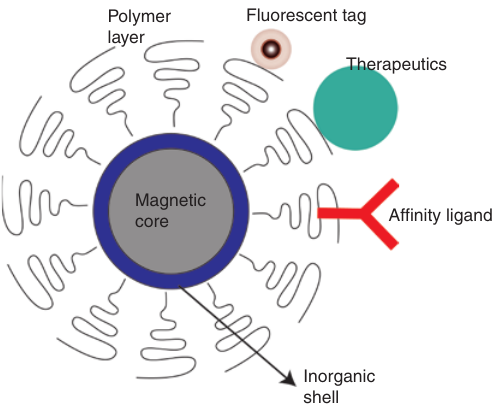
Figure 1: Design of magnetic nanoparticles for biomedical applica- tions. MNPs mostly consist of a magnetic core encapsulated by a protective inorganic shell bearing polymeric ligands displaying fluorescent tags for imaging, therapeutics, and affinity ligands for targeting and separation of biomolecules and